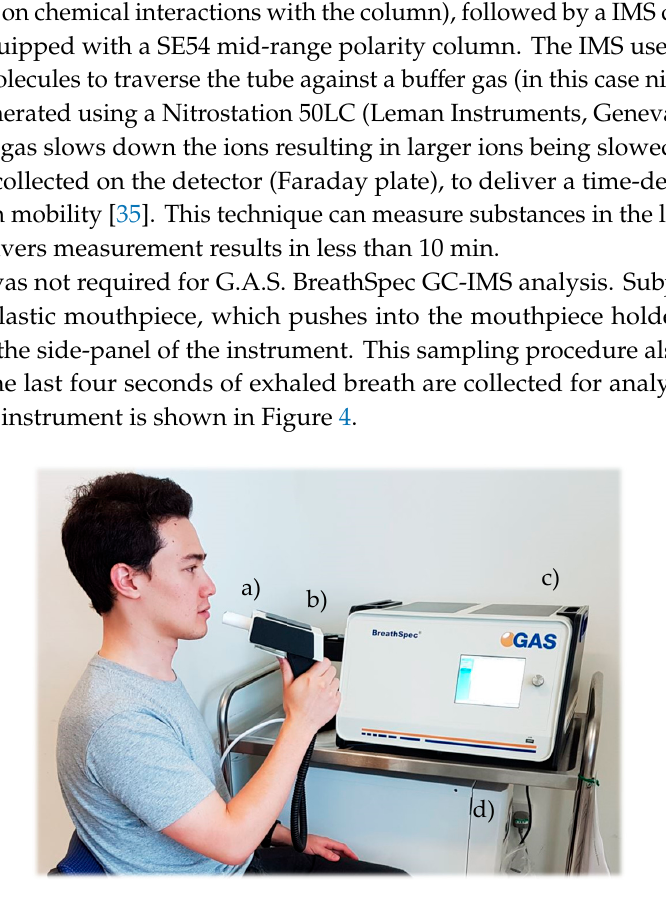
Figure 3. Wolf eNose typical sensor output responses.